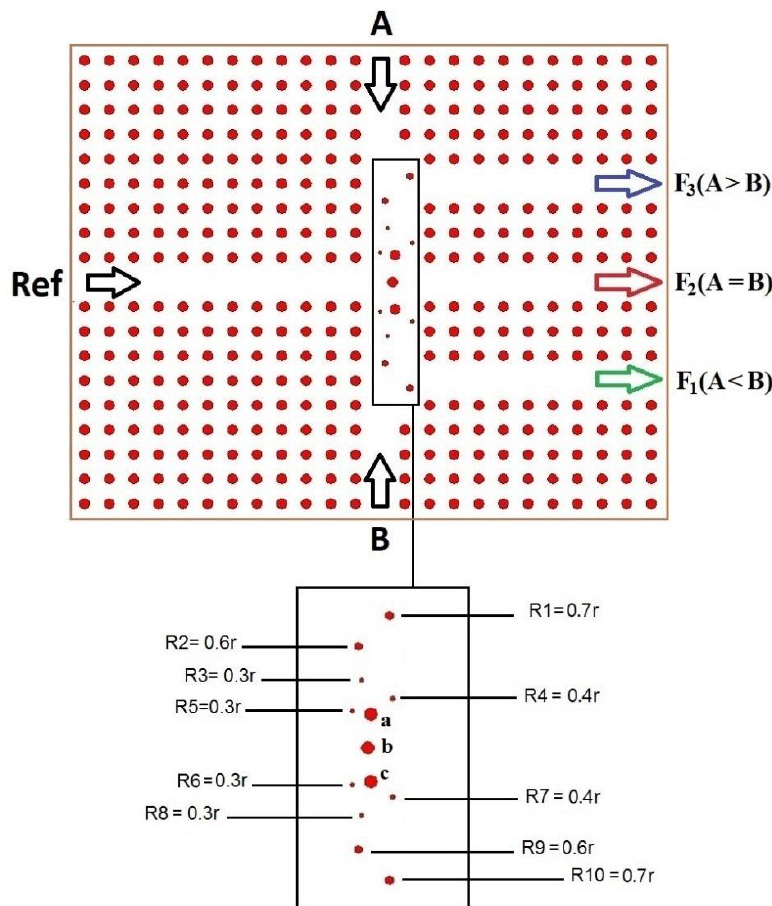
Figure 2. The proposed optical comparator structure.